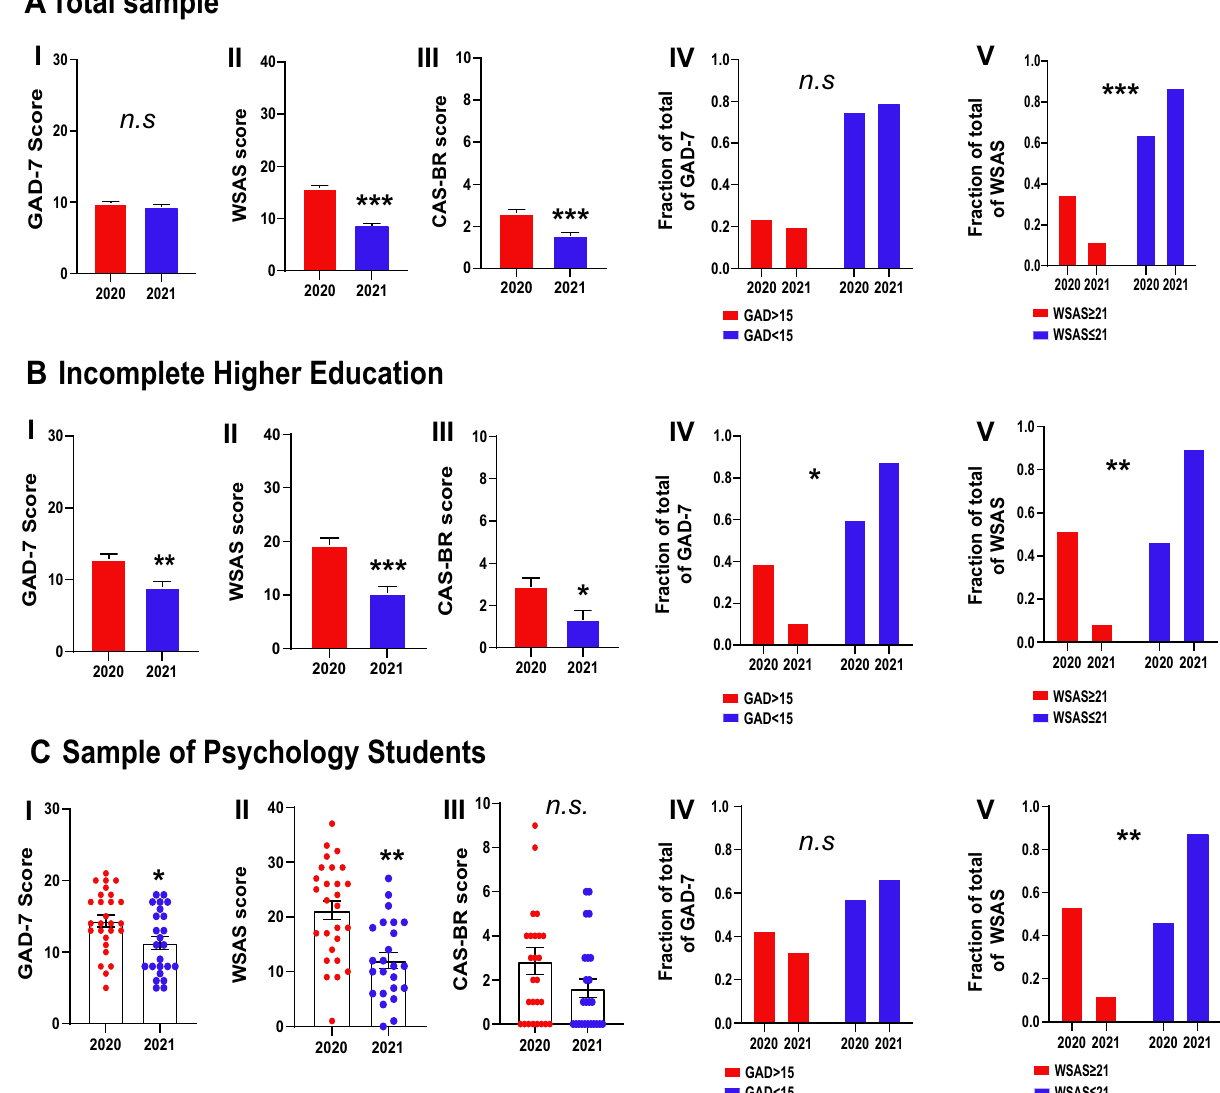
Figure 1. Comparisons of levels of anxiety, functional impairment, and coronavirus anxiety. (A) The total sample comprises the general population (N = 518 in 2020 and N = 427 in 2021). (B) Incomplete Higher Education group (N = 53 in 2020, and N = 42 in 2021) and (C) Psychology students’ group (N = 27 in 2020, and N = 24 in 2021). Comparison of 2020 and 2021 scores of ( I ) GAD-7, ( II ) WSAS, and ( III ) CAS-BR. Comparison of the proportion of ( IV ) GAD-7 > 15 and the ( V ) WSAS ≥ 21 scores between 2020 and 2021. The values were expressed by means ± SEM, the p-value was indicated by *p < 0.01, **p < 0.001, and ***p < 0.0001 and ‘n.s.’ indicating no difference among the samples. GAD-7 Generalized anxiety disorder scale, WSAS Work and social adjustment scale, CAS-BR Brazilian adapted version of the coronavirus anxiety